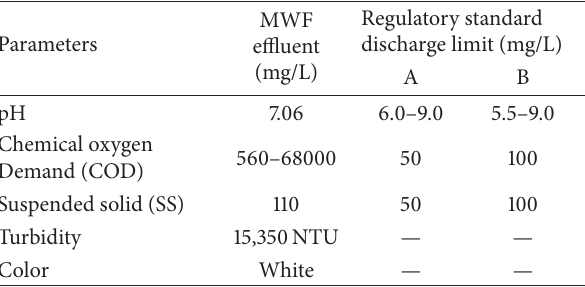
Table 1: The characteristics of MWF [2, 3, 12, 21–24] and regulatory discharge standard limits [32].